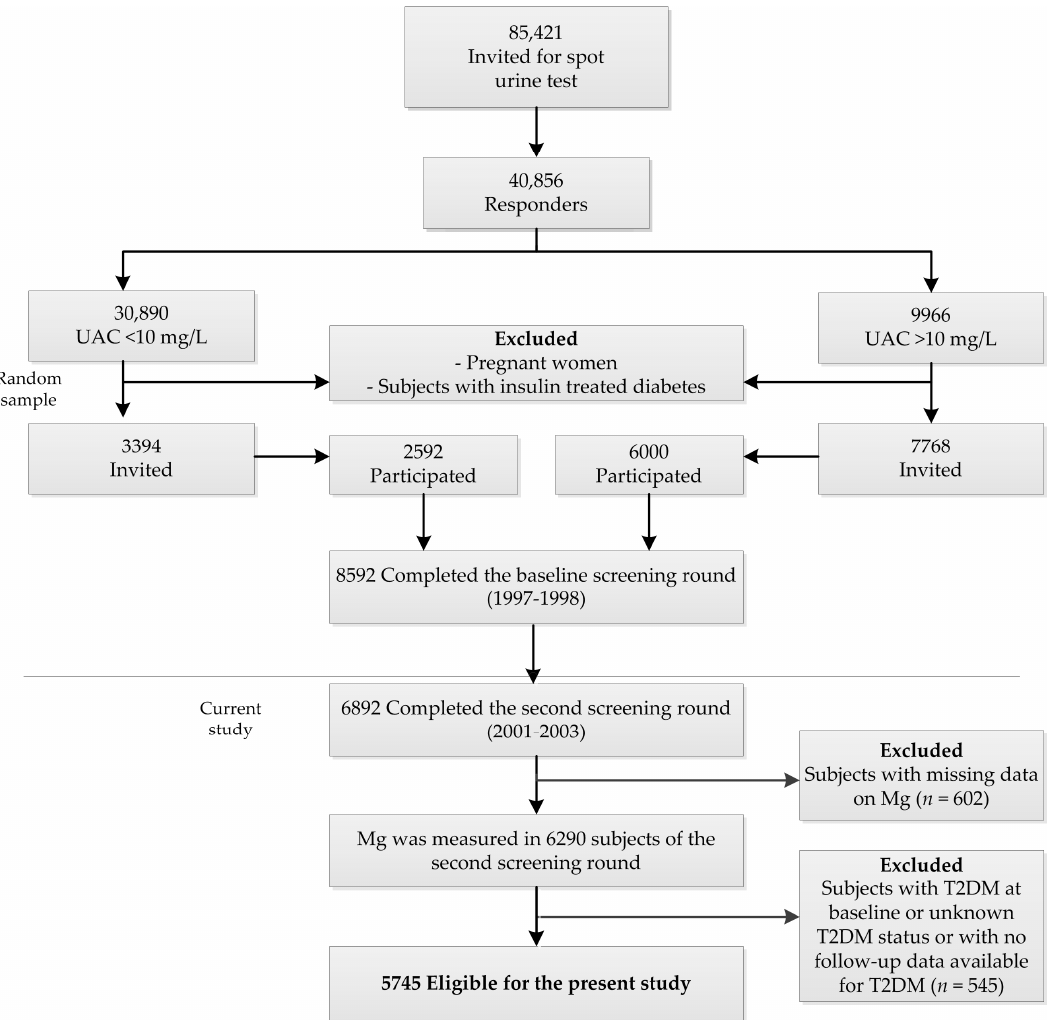
Figure 1. Flowchart of the Prevention of Renal and Vascular Endstage Disease (PREVEND) study participants included or excluded for the purposes of this study.